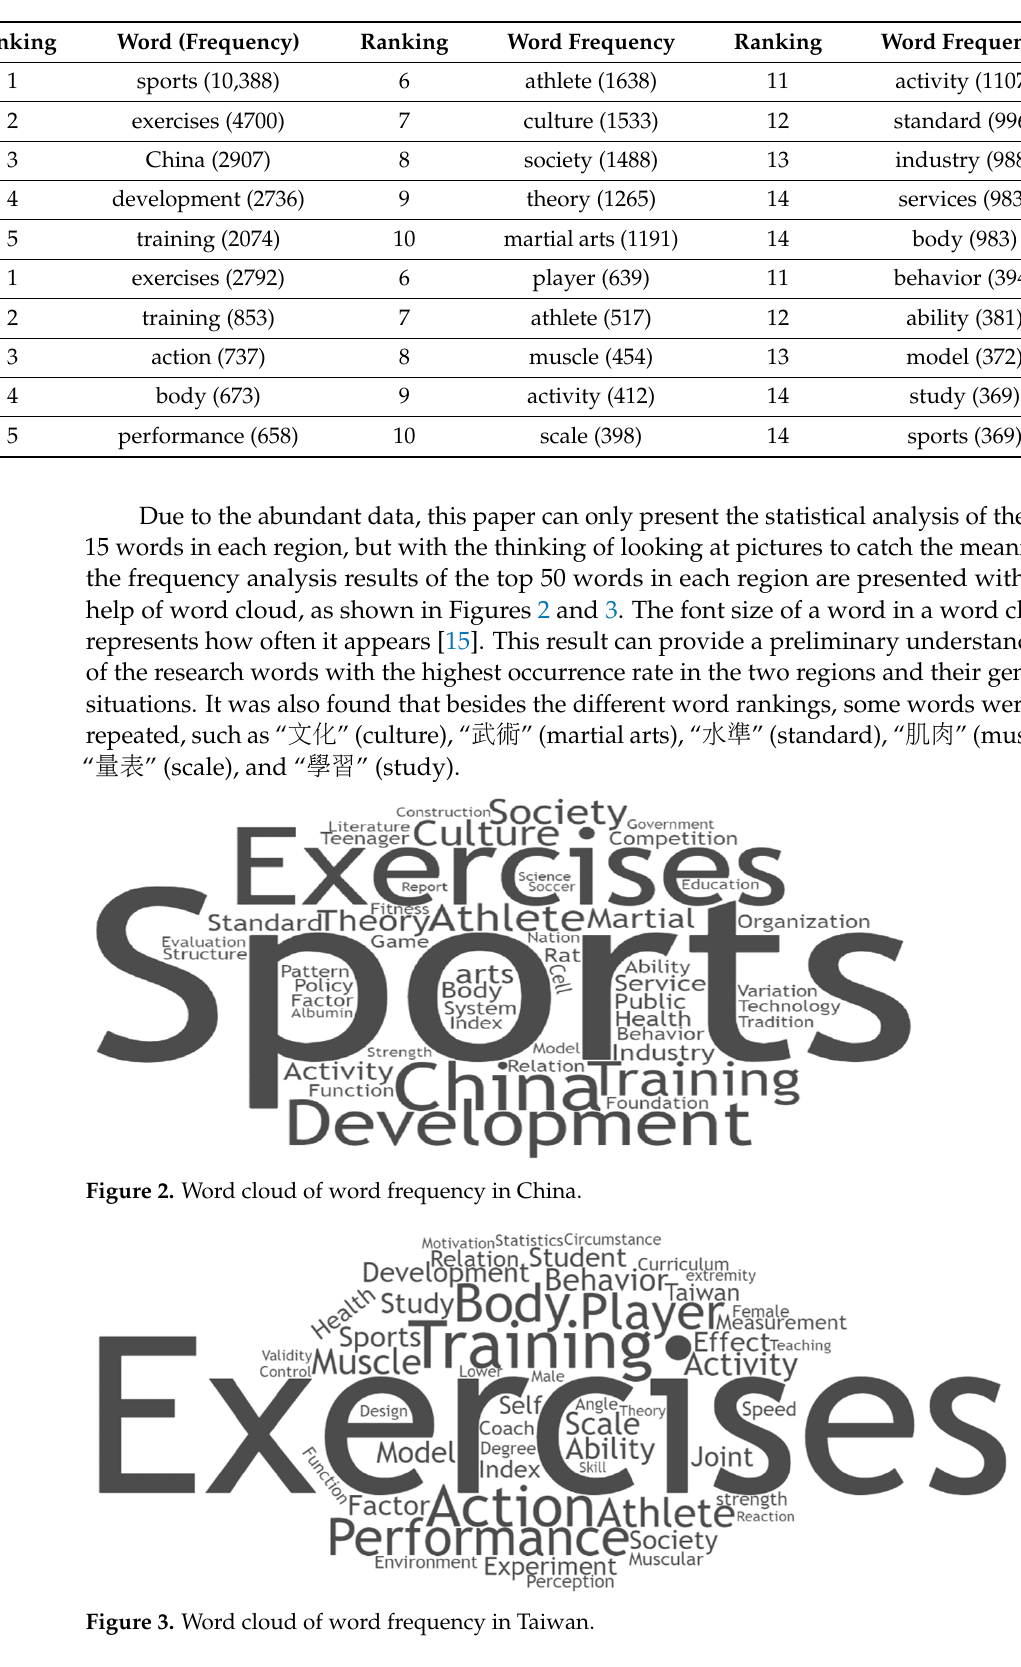
Table 1. Statistical analysis table of word frequency.